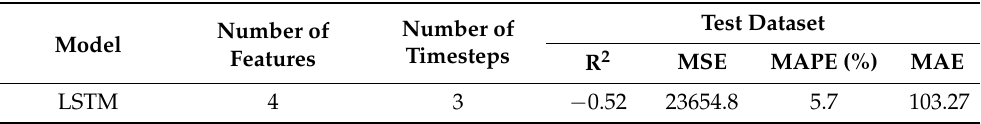
Table 11. Results of the LSTM model on the test set.